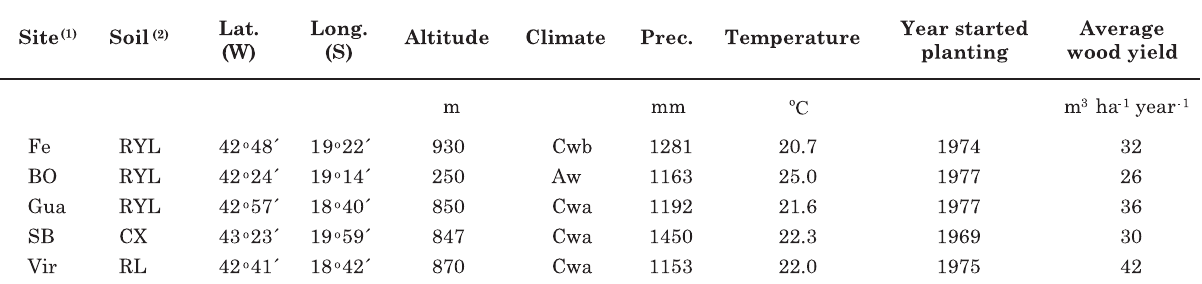
Table 1. Localization and characteristics of the studied sites and eucalyptus stands in the Rio Doce Valley